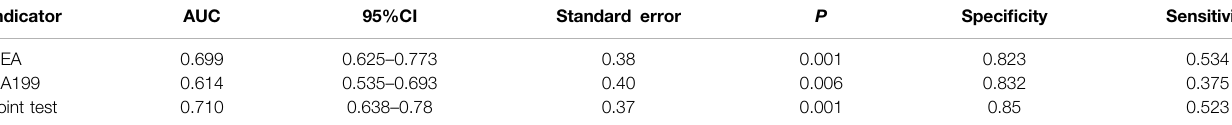
TABLE 5 | Value of CEA and CA199 levels to assessment of colorectal cancer patients.